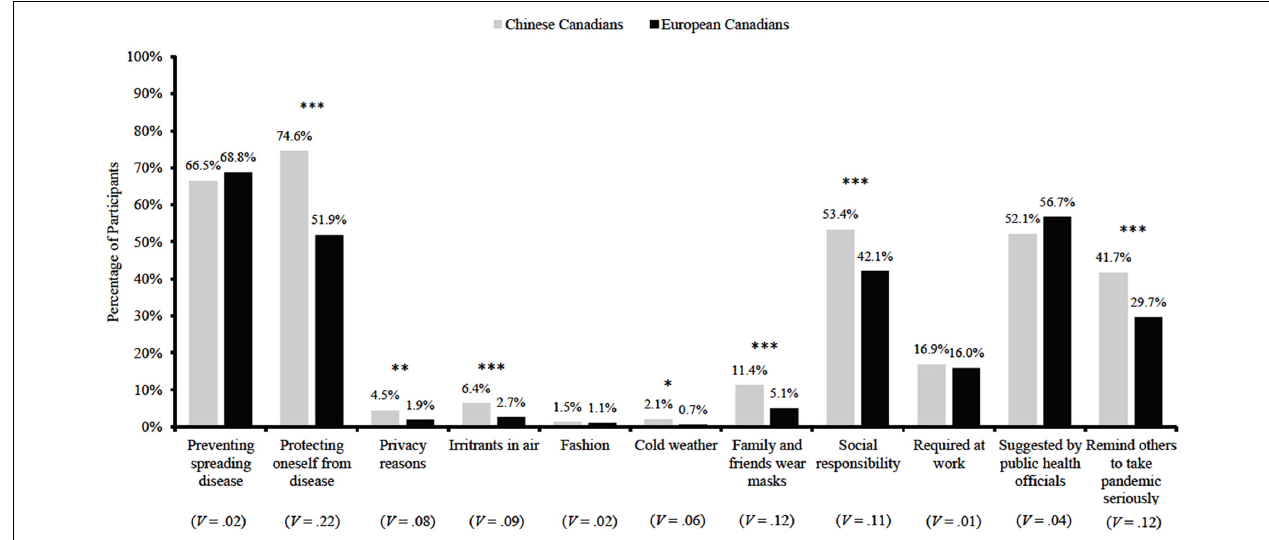
FIGURE 3 | Mask-wearing reasons among Chinese Canadians ( n = 528) and European Canadians ( n = 965) during the COVID-19 pandemic. ∗ P < 0.05, ∗∗ P < 0.01, ∗∗∗ p < 0.001, V , Cramer’s V